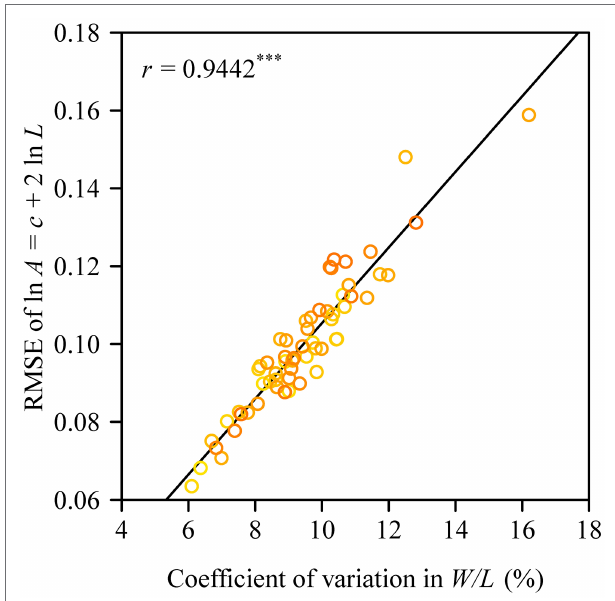
FIGURE 6 | Correlation between the goodness of fit based on the principle of similarity (assuming a square relationship between leaf area and leaf length) and the coefficient of variation in the ratio of leaf width to length. The y -label represents the root-mean-square error of the linear regression for the relationship between leaf area and the square of leaf length on a log–log scale; and r is the correlation coefficient, with three asterisks indicating p < 0.001.